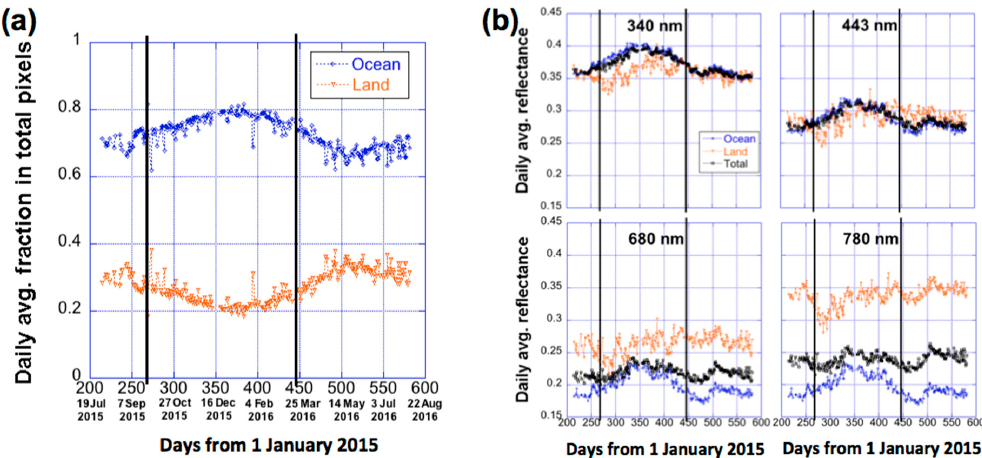
Figure 4. Time-series of ( a ) daily average fractions of land and ocean in sunlit face of Earth, and ( b ) the corresponding daily average reflectance over land and ocean from July 2015 to August 2016. Black curve is the daily average reflectance for the total sunlit face and is used as a reference here. The two vertical black lines represent the two equinox dates of 23 September 2015 and 20 March 2016.